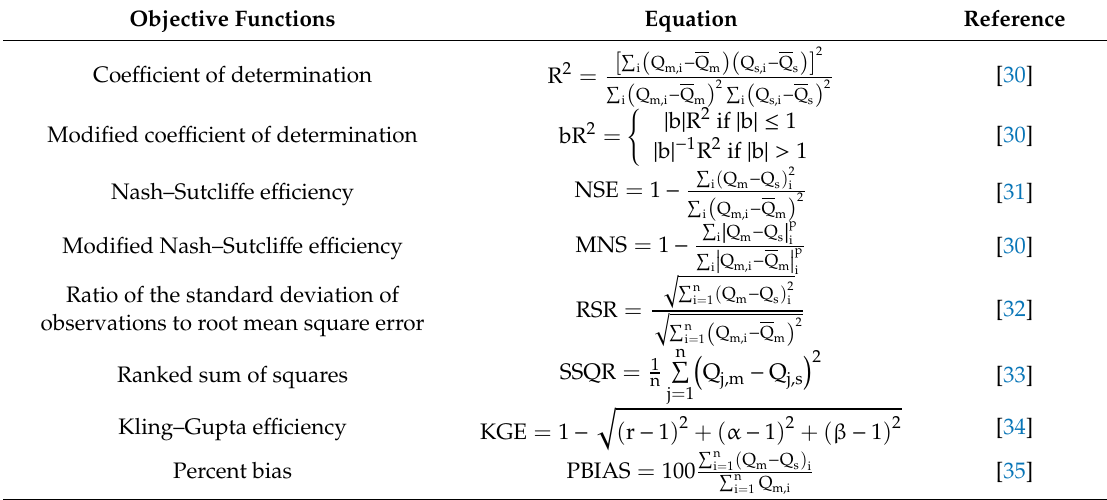
Table 3. List of objective functions used in this